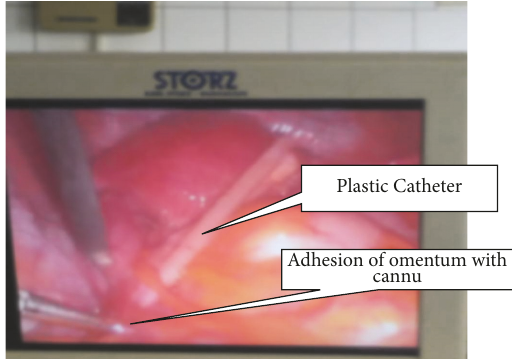
Figure 1: Laparoscopic image showing the foreign body buried in omental adhesion.